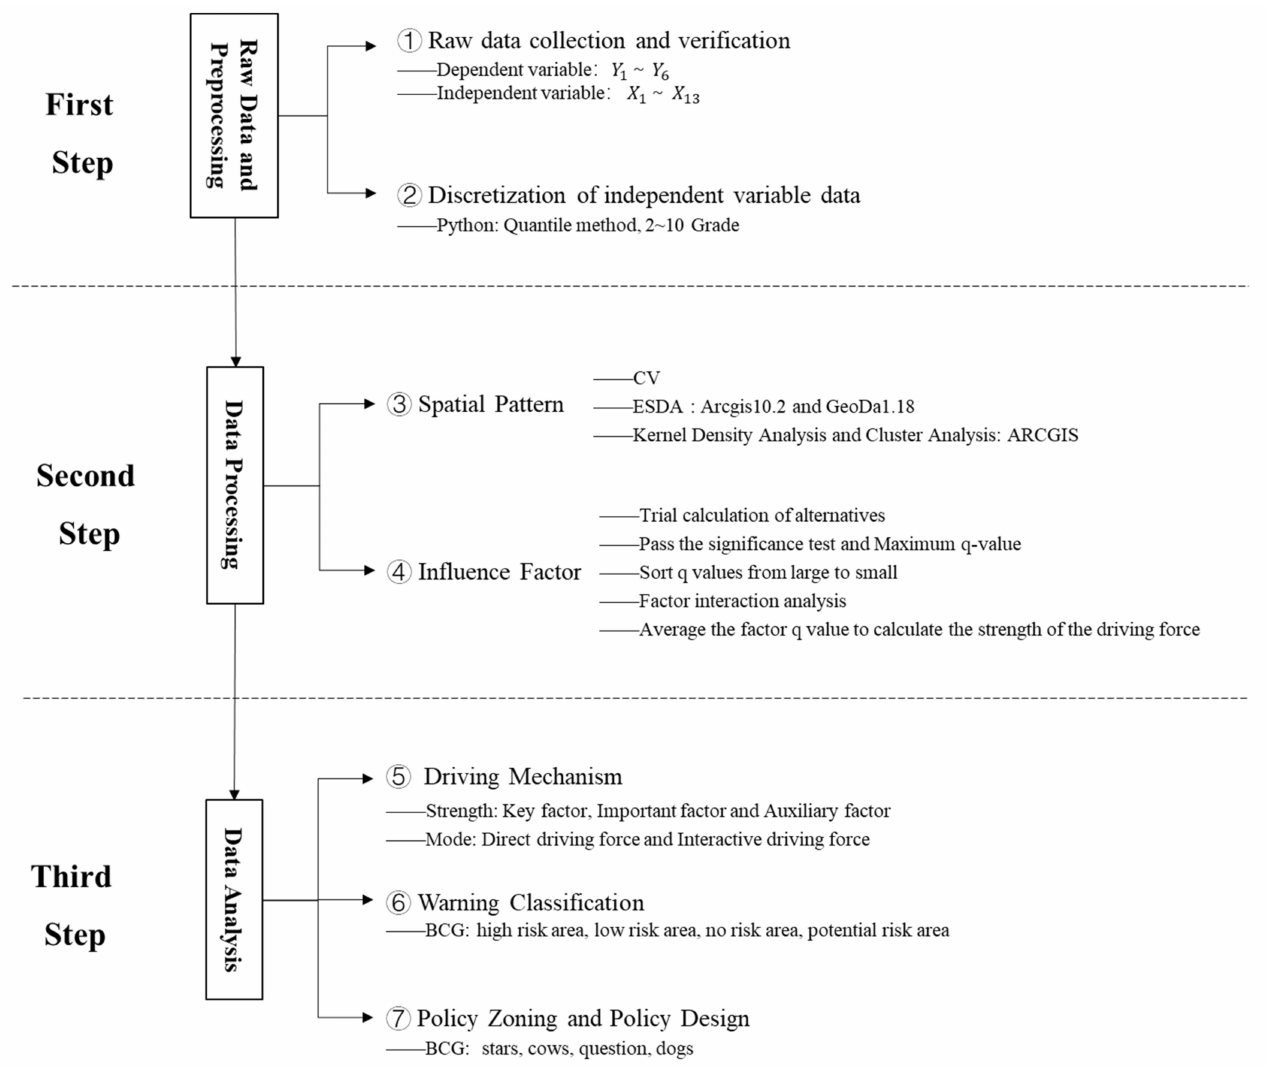
Figure 5. Research